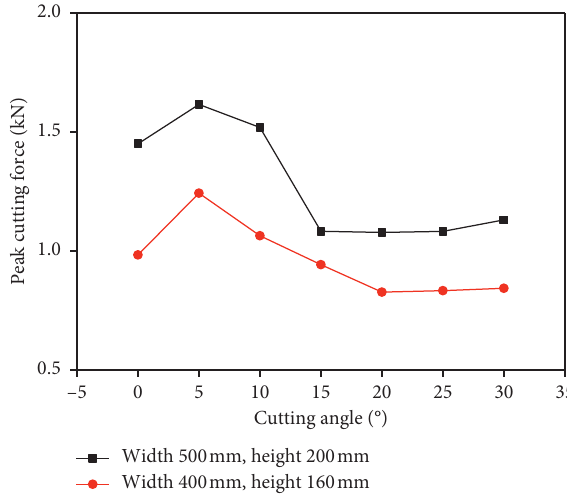
Figure 17: Variation in peak cutting force with cutting angle.